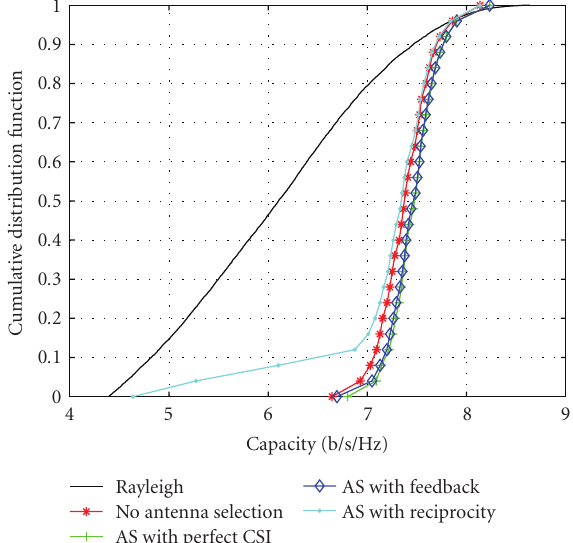
Figure 7: The cumulative distribution function of capacity at Location 2.